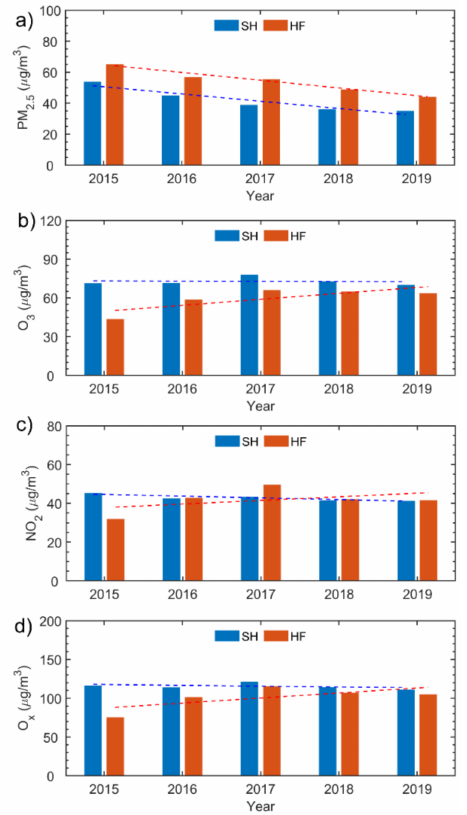
Figure 2. Annual mean concentrations (unit: µ g/m 3 ) of ( a ) PM 2.5 , ( b ) O 3 , ( c ) NO 2 , and ( d ) O x in Shanghai (SH, blue bars) and Hefei (HF, red bars) over the period 2015–2019. Dashed lines show the long-term